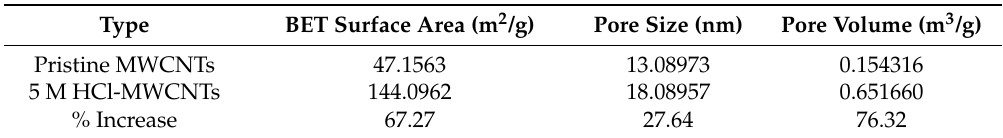
Table 2. Surface area of pristine and 5 M HCl functionalized